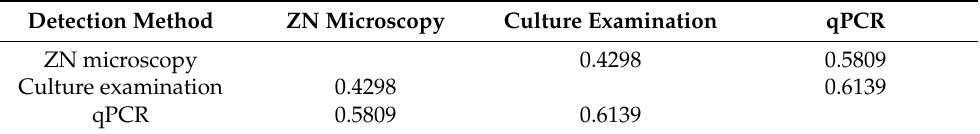
Table interpretation. CFU = colony forming units; TNTC = too numerous to count. ZN = microscopy examination after the Ziehl-Neelsen staining in at least 200 fields [43]; qPCR = quantitative PCR